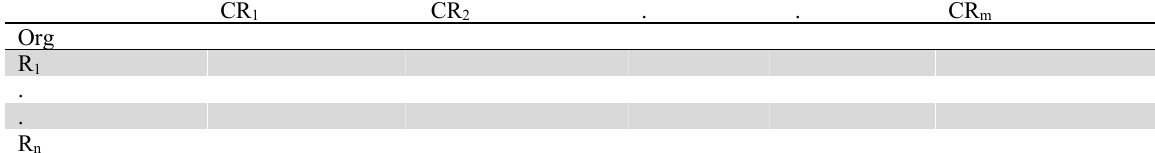
Evaluate of the organization and competitors in the field of the substantiation of the demands CR 1 CR 2 . . CR m